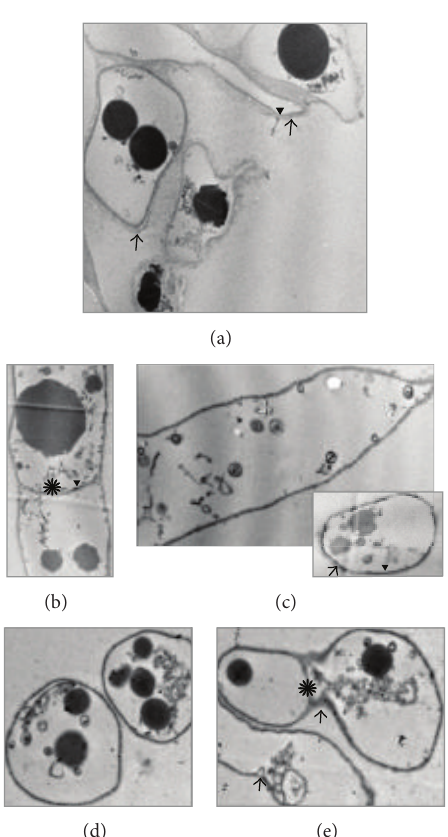
Figure 4: Ultrastructural features of Pleurotus ostreatus hyphae depending on Se concentration in the medium. (a) Control; (b) and (c) 100.0 mgL −1 ; (d) and (e) 500.0 mgL −1 ( × 15000). → : cell wall; 󳶃 : cell membrane; ∗ :